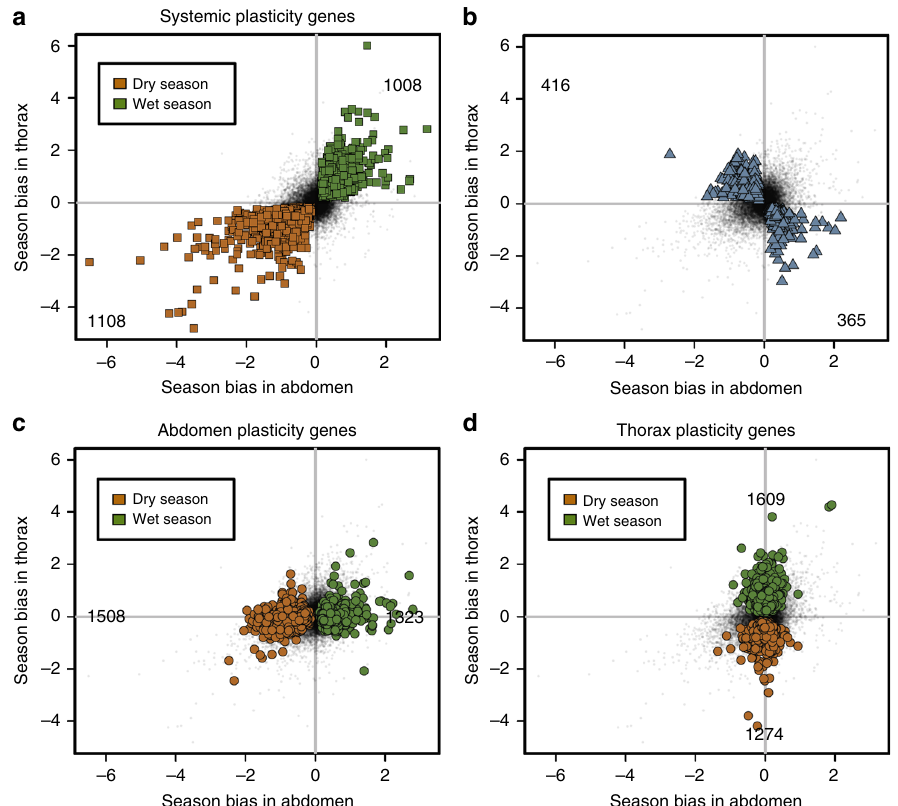
Fig. 2 Systemic and tissue-speci fi c components of the plasticity programme. For each gene expressed in both body parts, seasonal expression bias (log 2 fold change of expression in wet season compared to dry season) in thorax (vertical axis) is plotted against expression bias in abdomen (horizontal axis), with positive fold change values indicating higher expression in wet season, and negative values indicating higher expression in dry season. Each gene is represented by a black dot, and genes signi fi cantly differentially expressed (FDR < 0.05) between wet and dry season are coloured in green and brown for wet and dry season-biased genes, respectively ( a , c , d ), or in blue ( b ). Numbers in each quadrant indicate numbers of signi fi cant wet or dry season-biased genes. a The systemic plasticity programme is represented by 2115 genes that show the same response to the seasonal environment in both body parts, representing 14 and 17% of the abdomen and thorax transcriptome, respectively, and enriched for 89 functional GO terms. b Expression for 781 genes shows opposite patterns of season bias between the two body parts, i.e., expression is wet season-biased in one body part and dry season-biased in the other body part. These genes are enriched for 37 GO terms. c , d The abdomen- and thorax-speci fi c plasticity programmes are represented by 32 and 30% of genes in each body part, and are enriched for 155 and 189 GO terms. This includes genes expressed in both body parts but season-biased in only one (presented in this fi gure), as well as genes expressed exclusively in one body part (Supplementary Notes). Selected GO terms are visualised in Supplementary Fig. 8, all GO terms are listed in Supplementary Data 2, and a list of all season-biased gene is presented in Supplementary Data